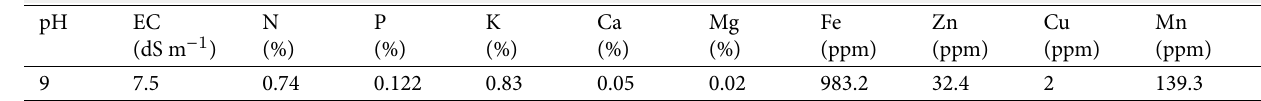
Table 2 Some chemical properties of biochar used in the experiment.